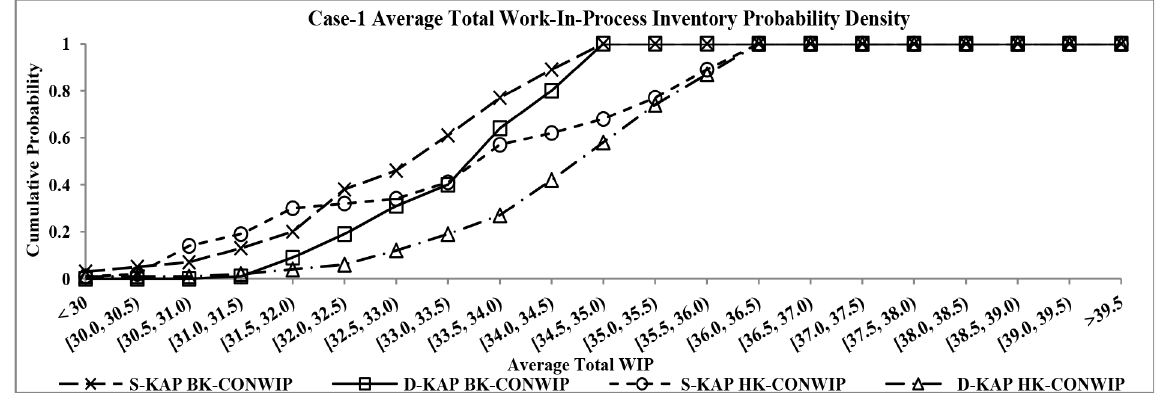
Figure 7. Case-1 cumulative distribution function plot of average total WIP